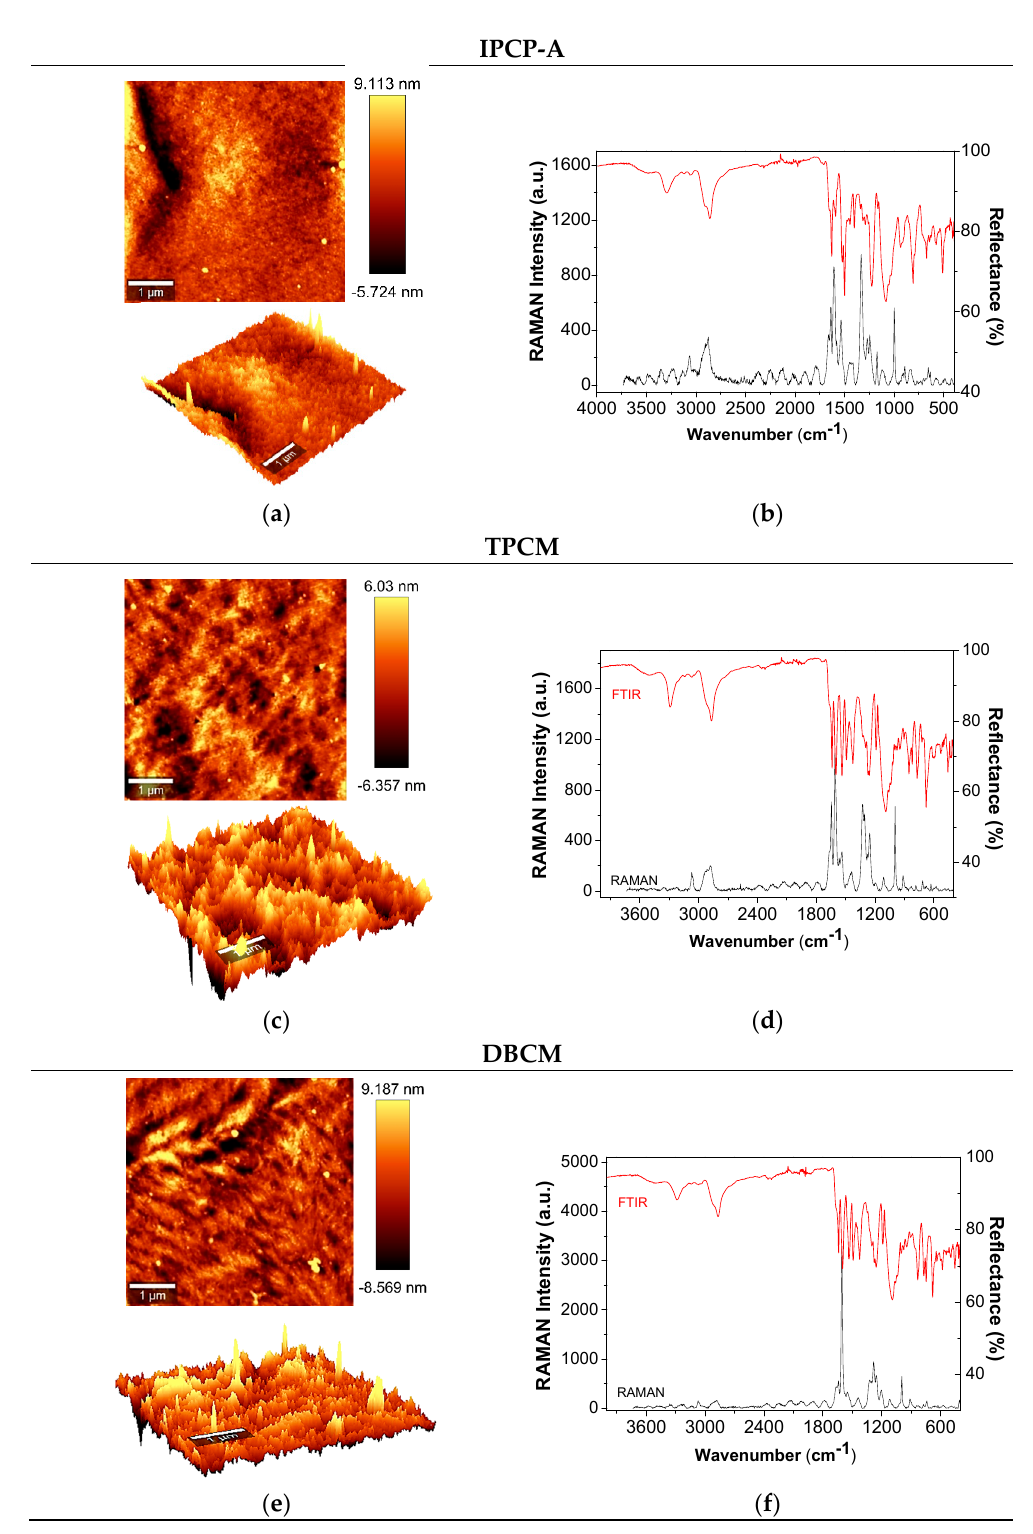
Figure 5. AFM topography images (surface and 3D) in tapping mode of ( a ) IPCP-A, ( c ) TPCM, and ( e ) DBCM. FTIR and RAMAN spectra of ( b ) IPCP-A, ( d ) TPCM, and ( f ) DBCM. Topography 3D images in the AFM characterization show the soft blocks (black) and harder blocks (yellow). Soft and hard regions appear to be distributed homogeneously in the surface of the films for all the polymers. The penetration of the AFM tip in the soft